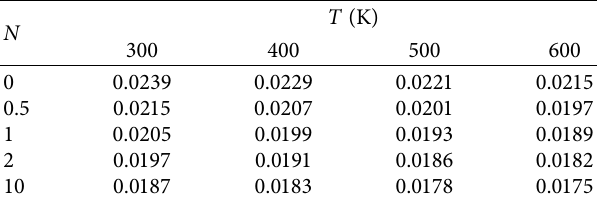
Table 6: First nondimensional natural frequencies ϖ of ZrO